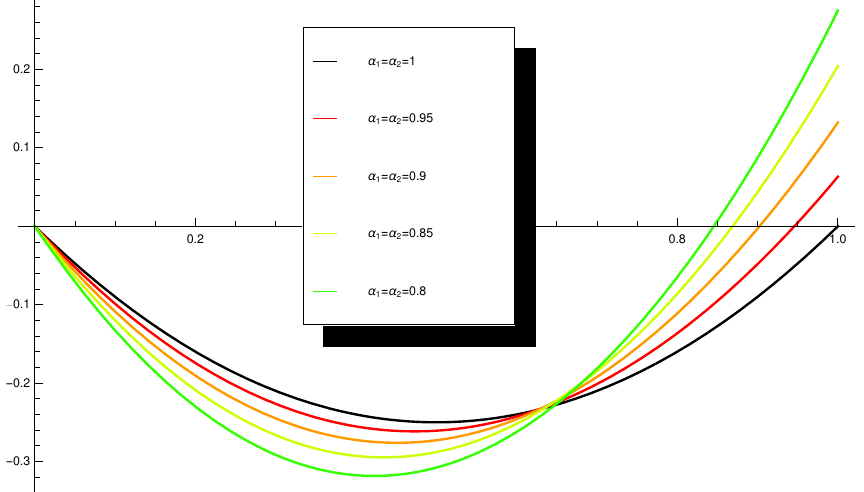
Figure 7. Approximate solutions x 1 of (20) for several values of α 1 and α 2 .